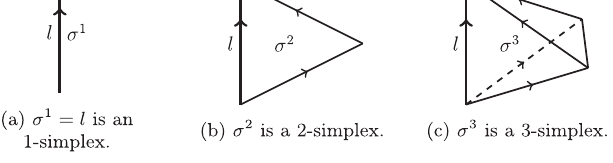
FIG. 12. Regular pairs l ⊆ σ i ( i ¼ 1 , 2, 3) for link l